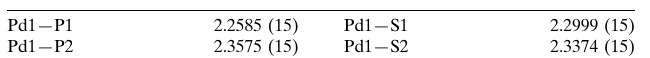
Selected bond lengths (A˚